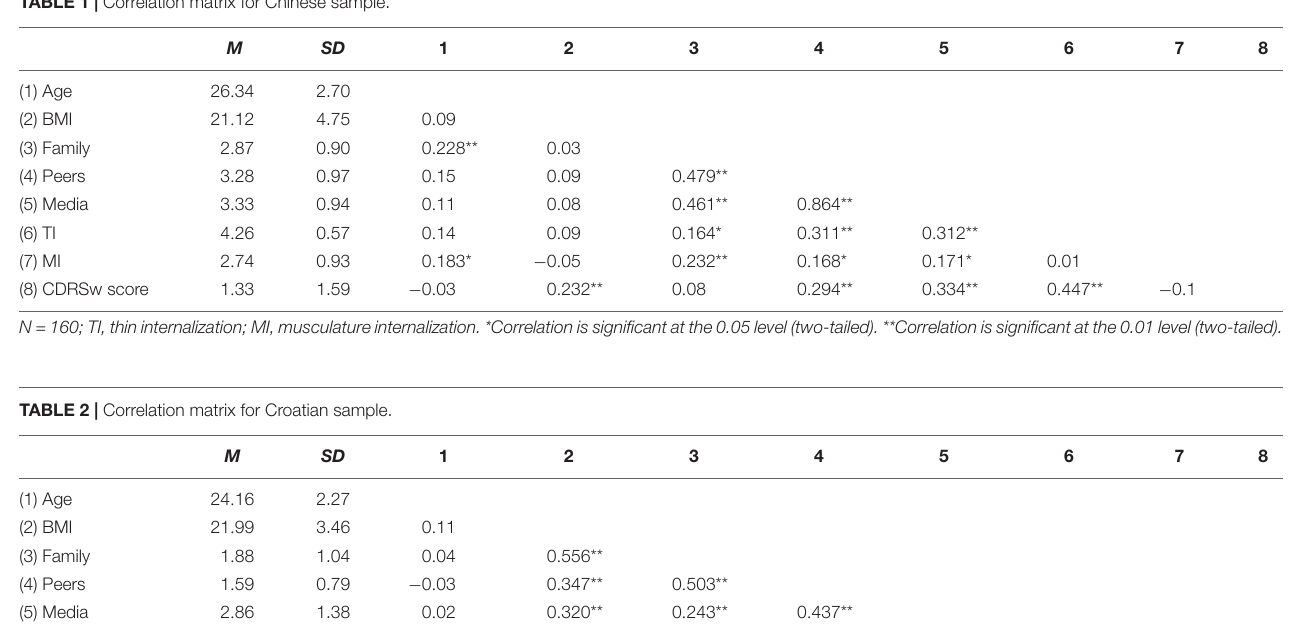
TABLE 1 | Correlation matrix for Chinese sample.